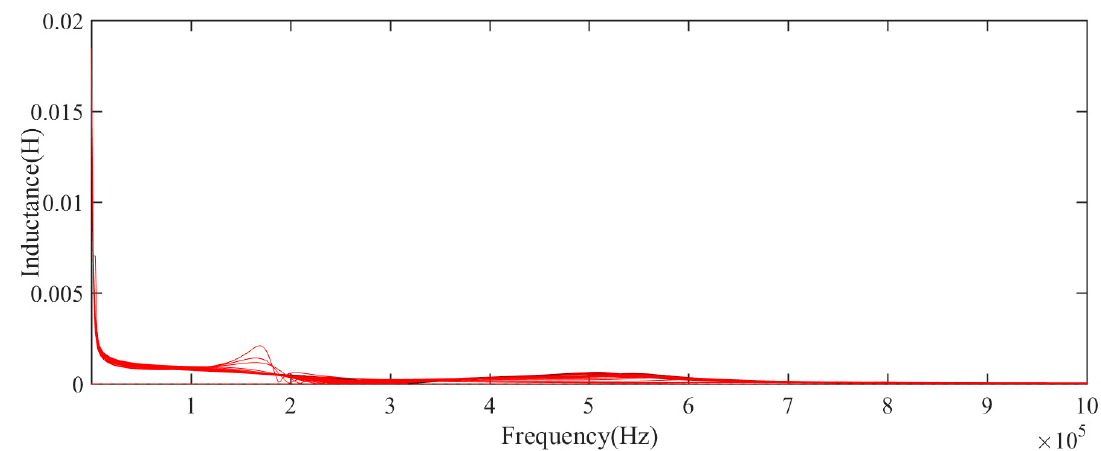
Figure 5. The measurement value of resistance spectra of the electromagnetic coil in the whole life.